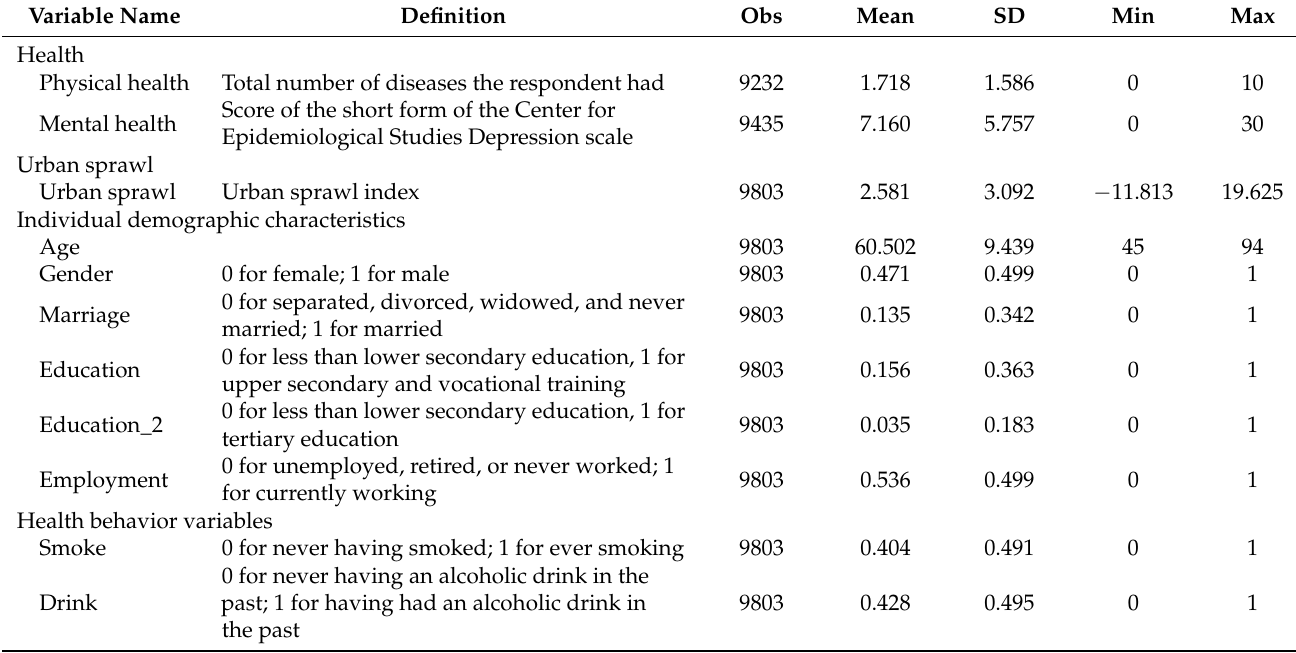
Table 1. Descriptive statistics of the main